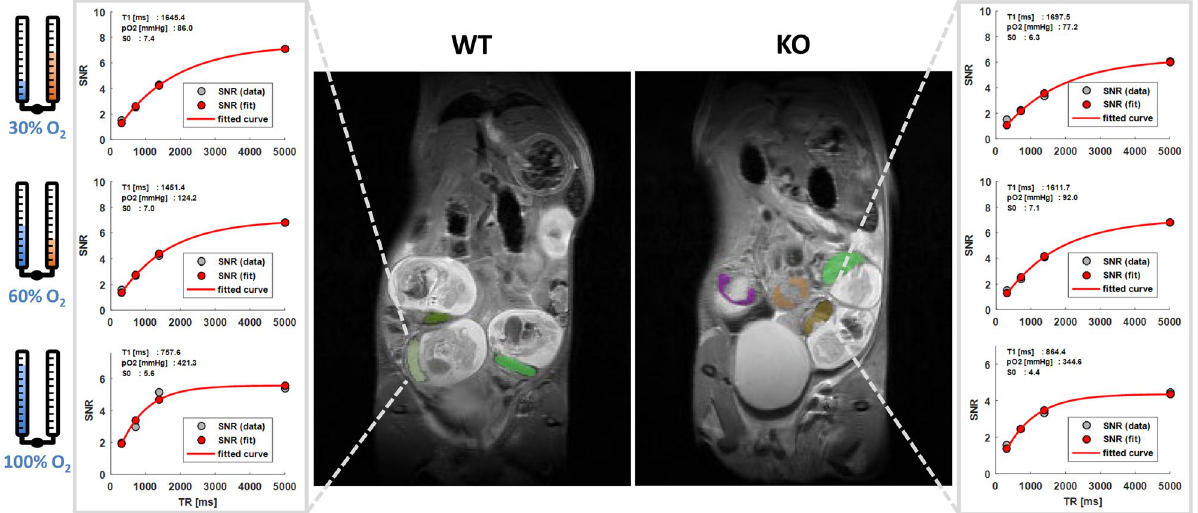
Figure 2. Example data from wildtype (WT) and Lgals1 − / − knockout (KO) animal. Colorcoded overlay of placental volumes of interest on anatomical T 2 -weighted MR images. Corresponding mean 19 F MRI SNR, T 1 fits and calculated relative 19 F concentration S 0 and PO 2 in mmHg at different levels of oxygen in breathing air are shown for the two placentas marked by dashed